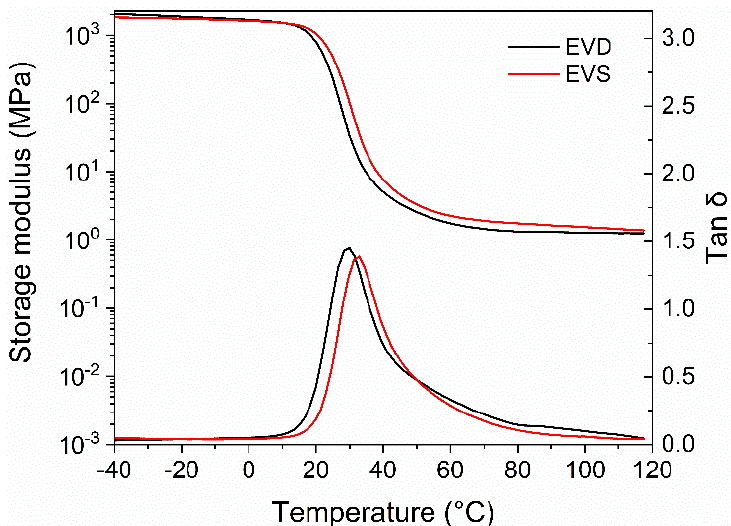
Figure 4. Storage modulus plots and tan δ plots of EVD and EVS.